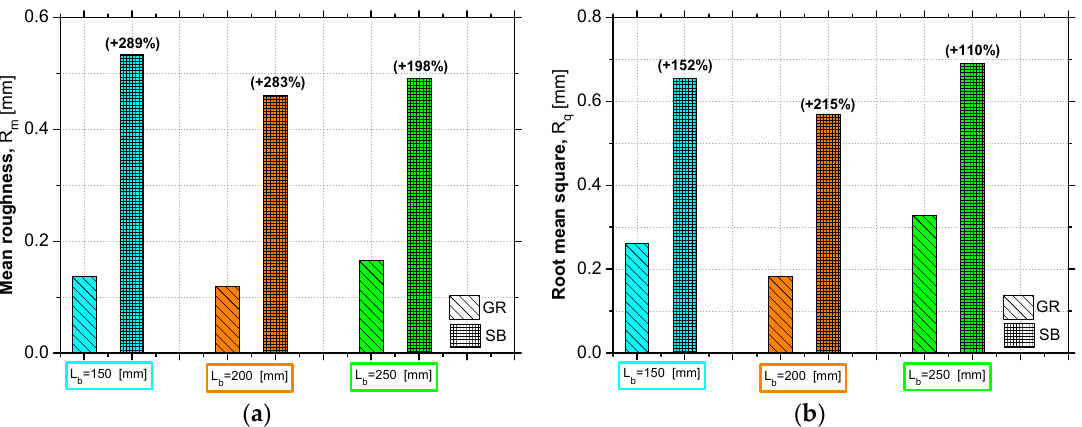
Figure 4. Roughness level comparison provided by each surface preparation method (GR and SB) in terms of: ( a ) mean roughness (R m ); ( b ) root mean square (R q ). Note: the values in parentheses represents the percentage increase when SB was applied instead of GR.